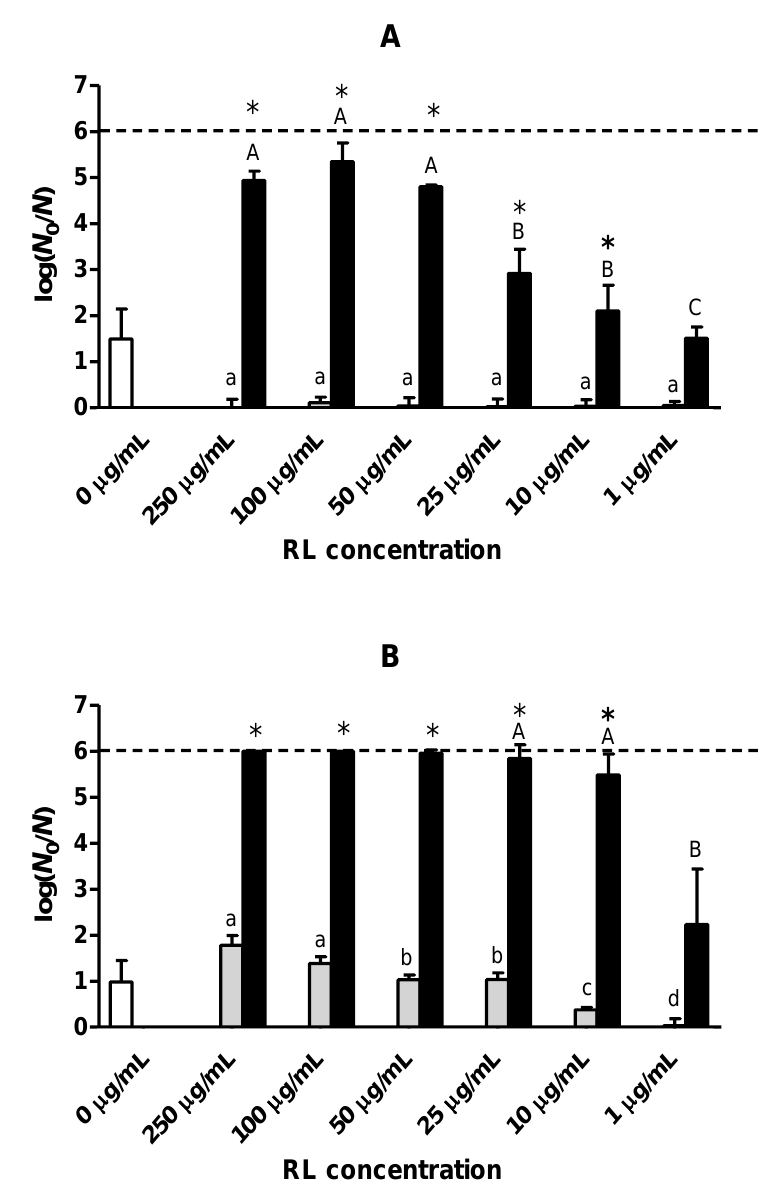
Figure 2. Logarithmic reduction factor (LRF; log( N 0 /N)) of L. monocytogenes Scott A in sodium phosphate buffer (pH 6.7) of a w 0.92 with ( A ) glycerol or ( B ) NaCl by heat, RL at different concentrations and the combination of heat and RL. The white bar represents heat inactivation alone (60 °C, 5 min; without RL added). For each RL concentration, the gray bar presents inactivation by RL at room temperature (~20 ◦ C, 5 min), while the black bar indicates inactivation by the combination of RL and heat (60 °C, 5 min). The dashed line indicates the maximum detectable LRF corresponding to the quantification limit (1000 CFU/mL). Error bars represent the standard deviations of the means of triplicates. Asterisk indicates statistically significant differences ( p ≤ 0.05) between the theoretical additive inactivation by heat and RL and the experimental inactivation obtained by the combined treatment, and therefore the occurrence of a synergistic lethal effect. Lowercase and capital letters indicate statistically significant differences ( p ≤ 0.05) in the inactivation by RL and by the combination of heat and RL treatment, respectively, among the different RL concentrations tested.